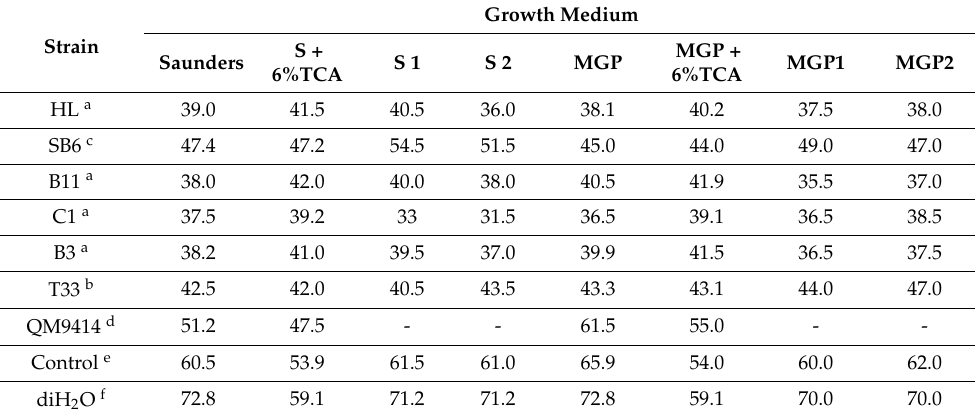
Table 1. Values of surface tension [mN/m] by the physical ring tear-off method for culture fluids obtained in culture of selected Trichoderma strains ( T. citrinoviride HL, C1, B3, B11; T. atroviride SB6; T. harzianum T33 oraz T. reesei QM9414) cultured in following media: Saunders, Saunders + 6% TCA (S + 6% TCA), Saunders 1 (S1), Saunders 2 (S2) and MGP, MGP + 6% TCA, MGP 1, MGP 2. Superscript letters ( a–f ) at strain designations represent significant differences between